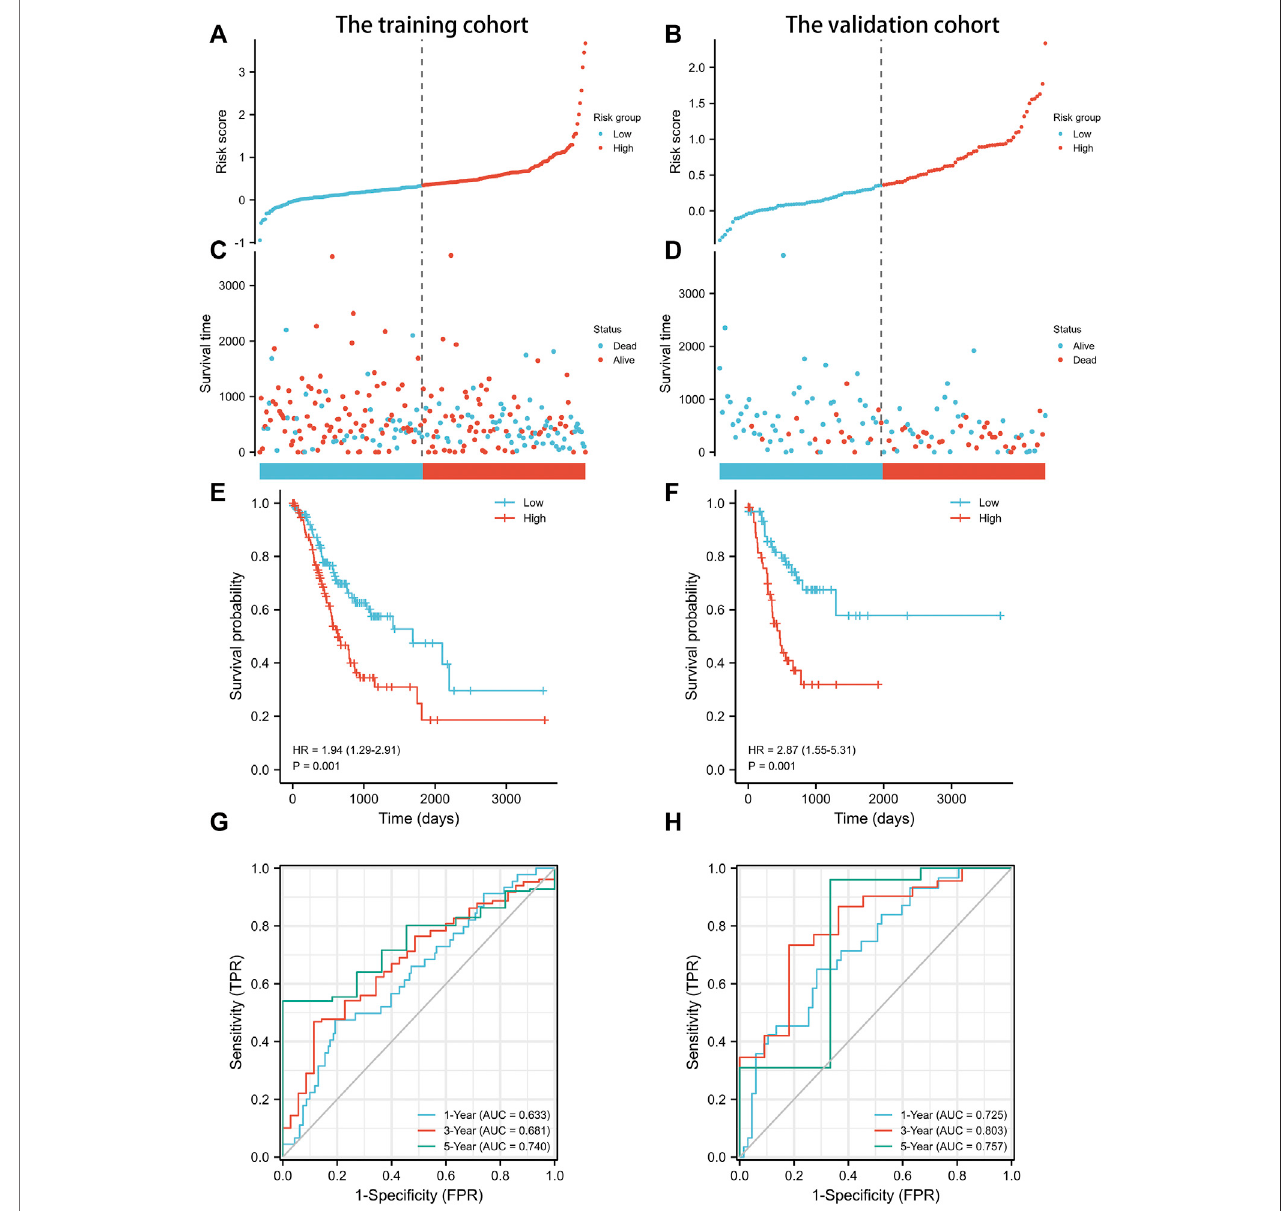
FIGURE 3 | Prognostic analysis of exosomes-related lncRNA signature in the training cohort and validation cohort. (A) The distribution of the risk scores in the training cohort. (B) The distribution of the risk scores in the validation cohort. (C) The distributions of overall survival status, overall survival, and risk score in the training cohort. (D) The distributions of overall survival status, overall survival, and risk score in the validation cohort. (E) Kaplan-Meier curves for the overall survival of patients in the high- and low-risk groups in the training cohort. (F) Kaplan-Meier curves for the overall survival of patients in the high- and low-risk groups in the validation cohort. (G) AUCoftime-dependent ROCcurves veri fi ed theprognostic accuracyoftheriskscoreinthetrainingcohort. (H) AUCoftime-dependentROCcurves veri fi ed the prognostic accuracy of the risk score in the validation cohort.